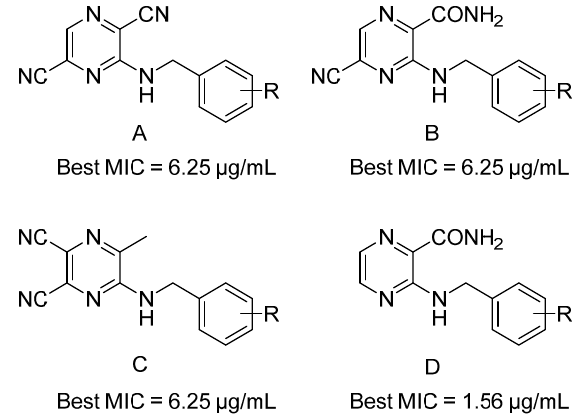
Figure 1. General structures of discussed compounds (A, B—Zitko et al. [16]; C—Jandourek et al. [17]; D—this work) and best MICs against M. tbc H37R v .